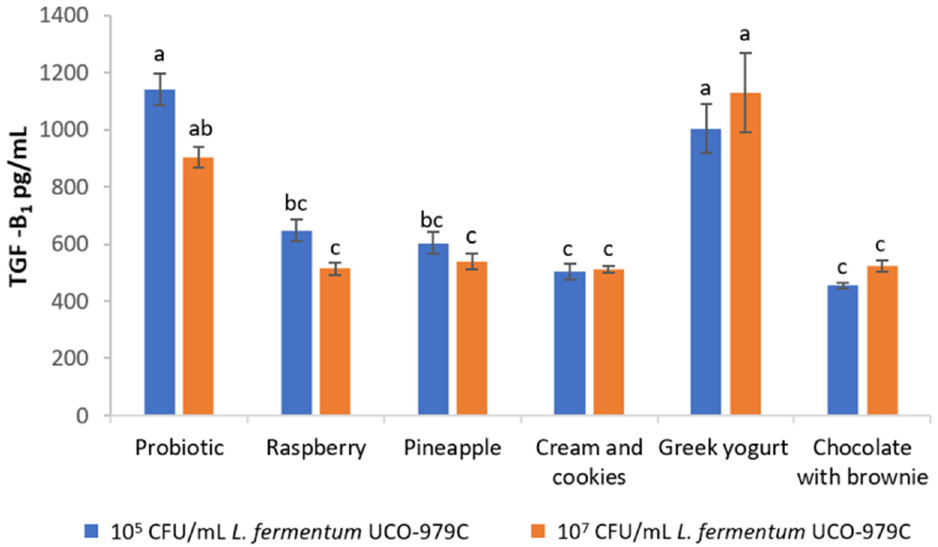
Figure 2. Production of TGF- β 1 cytokines by gastric epithelial cells (AGS) induced by the L. fermentum UCO-979C strain obtained from the different ice cream bases at 10 5 and 10 7 CFU/mL after 90 days of storage at − 18 ◦ C. The name of each ice cream corresponds to the L. fermentum UCO-979C strain obtained from each one of the flavors, and probiotic (control) corresponds to L. fermentum UCO-979C obtained directly from the lyophilizate. Means with different superscript letters are significantly different ( p < 0.05).